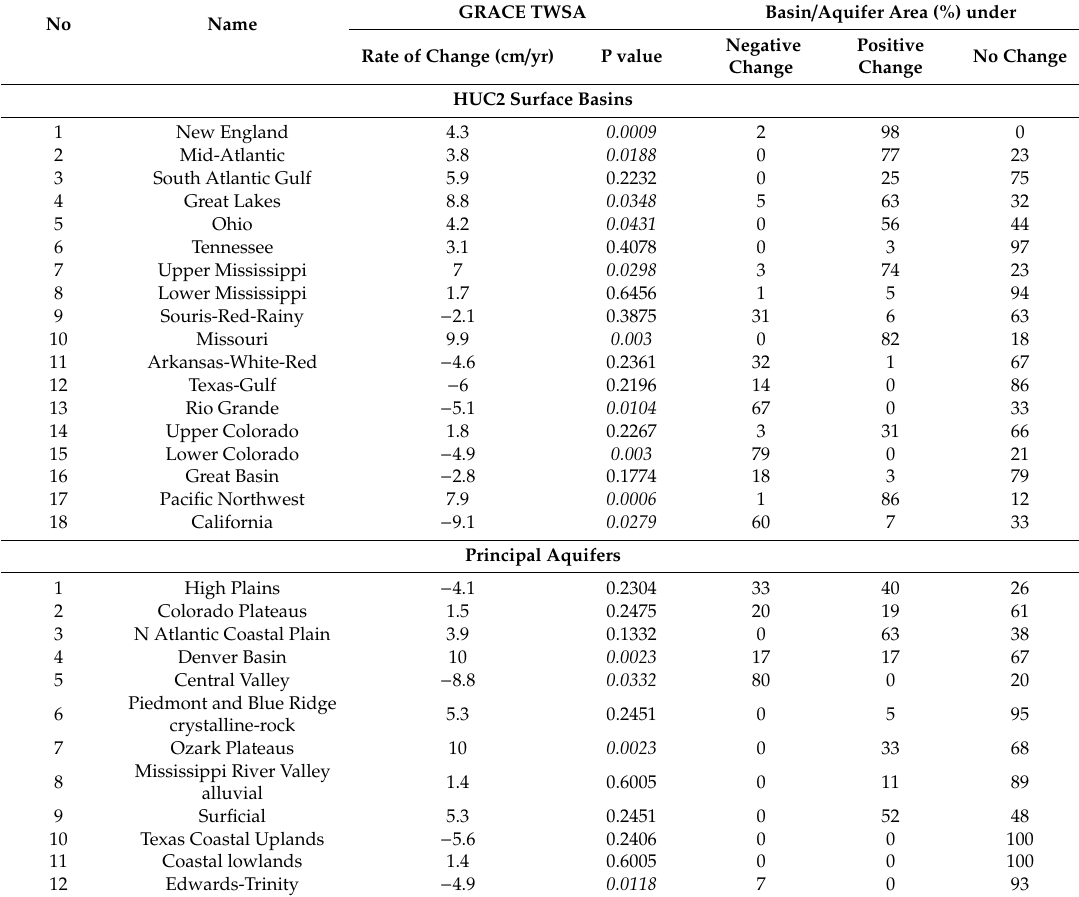
Table 4. Rate of change (cm / year) in storage and surface area under change derived using